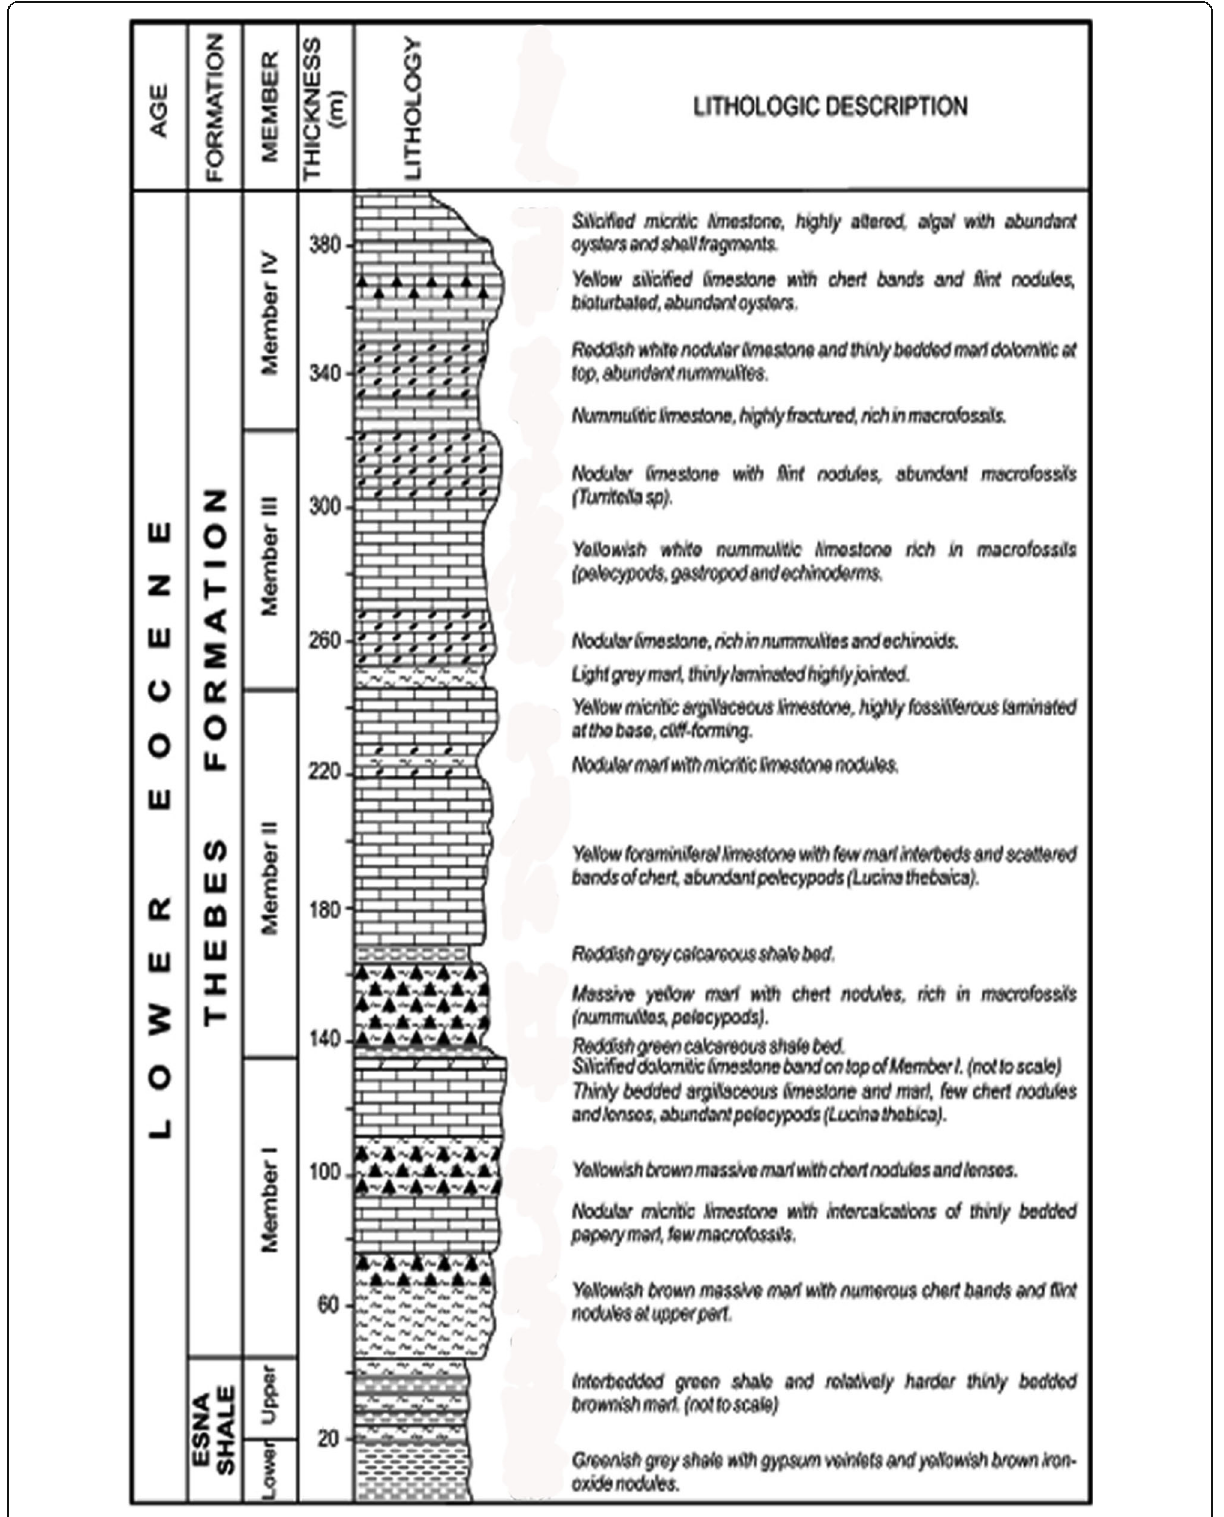
Fig. 2 Lithostratigraphic succession of Gebel El-Qurn, west Luxor, southern Egypt (after Said